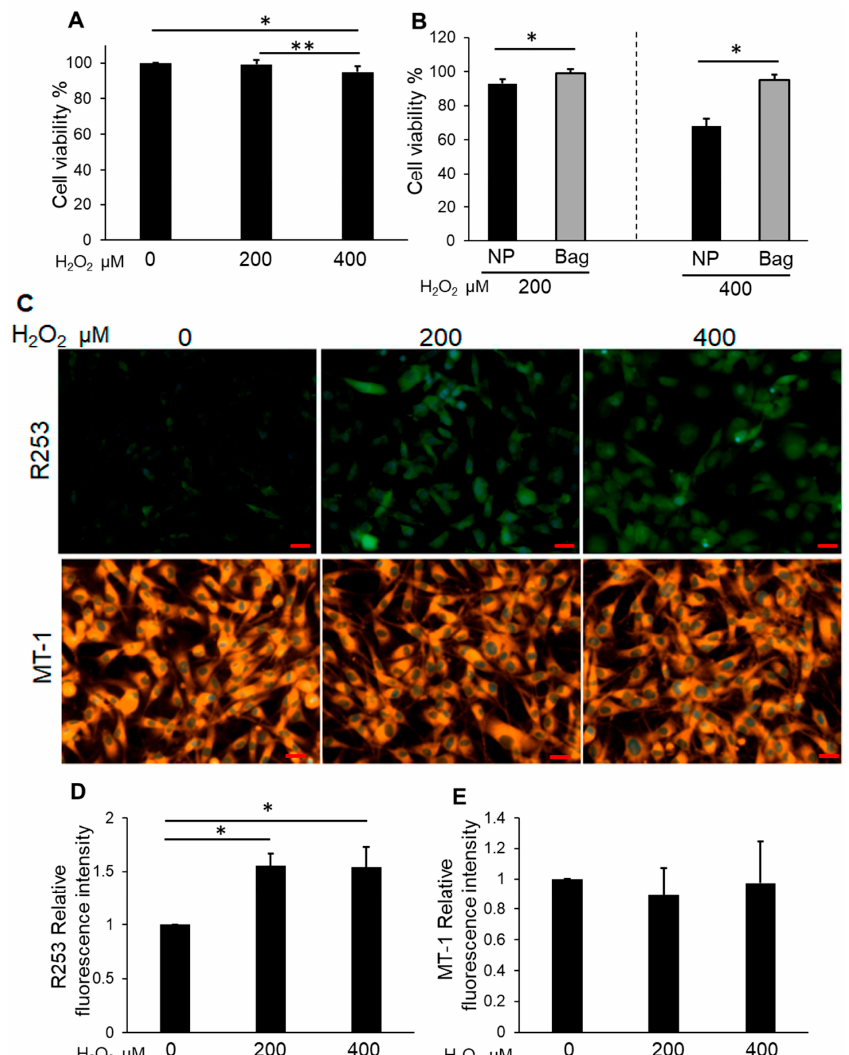
Figure 3. ( A ) Cell viability of H 2 O 2 -treated Bag-1-overexpressing NP cells. Cells were cultured in DMEM with between 200 and 400 µ M H 2 O 2 for 24 h. Data are the means ± SD n = 4, * p < 0.05, ** p < 0.05. ( B ) Comparison of the cell viability in NP cells (NP) and Bag-1 overexpressing NP cells (Bag) following treatment with H 2 O 2 for 24 h. Data are the means ± SD n = 4, * p < 0.05. ( C ) The upper row of the figure represents ROS production monitored using R253 (green) and the lower row is the mitochondrial membrane potential monitored using MT-1 (orange). The nucleus was detected by Hoechst 33342 reagent (blue). Although the detection of ROS production increased under H 2 O 2 treatment, the detection of MT-1 was maintained. Scale bars = 20 μ m. ( D ) Quantitative data of ROS production (R253) in Bag-1-overexpressing NP cells. Data are the means ± SD n = 3, * p < 0.05. ( E ) Quantitative data of the mitochondrial membrane potential (MT-1) in Bag-1- overexpressing NP cells. Data are the means ± SD n = 3.